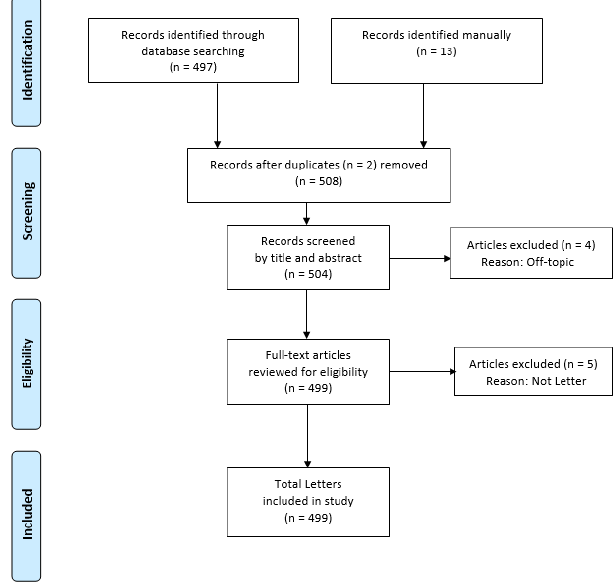
Figure 1 Source of Letters Included in Study. Adapted from Moher D, Liberati A, Tetzlaff J, Altman DG;